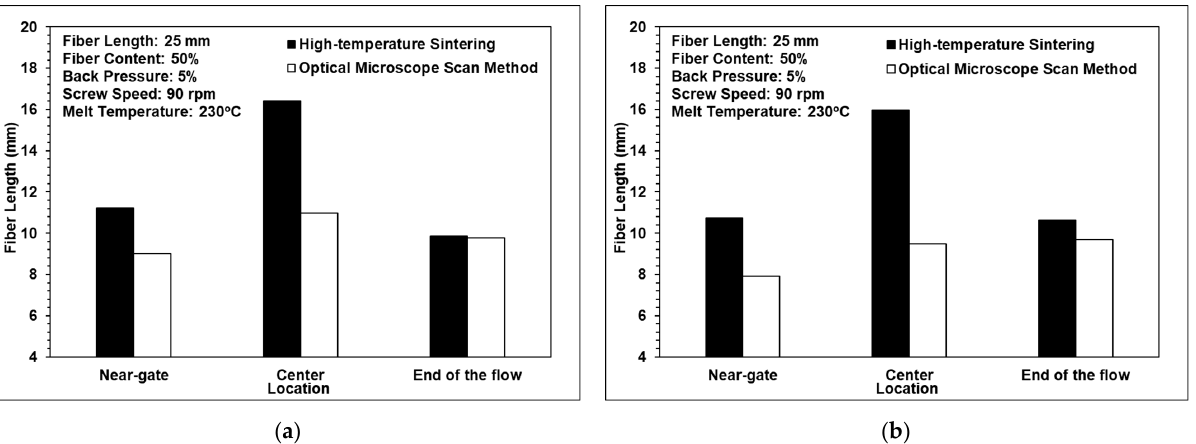
Figure 7. Comparison of fiber lengths using high-temperature sintering and optical microscopy for ( a ) the single-edge gate and ( b ) the single-sprue gate. ( a ) the single-edge gate and ( b ) the single-sprue gate.